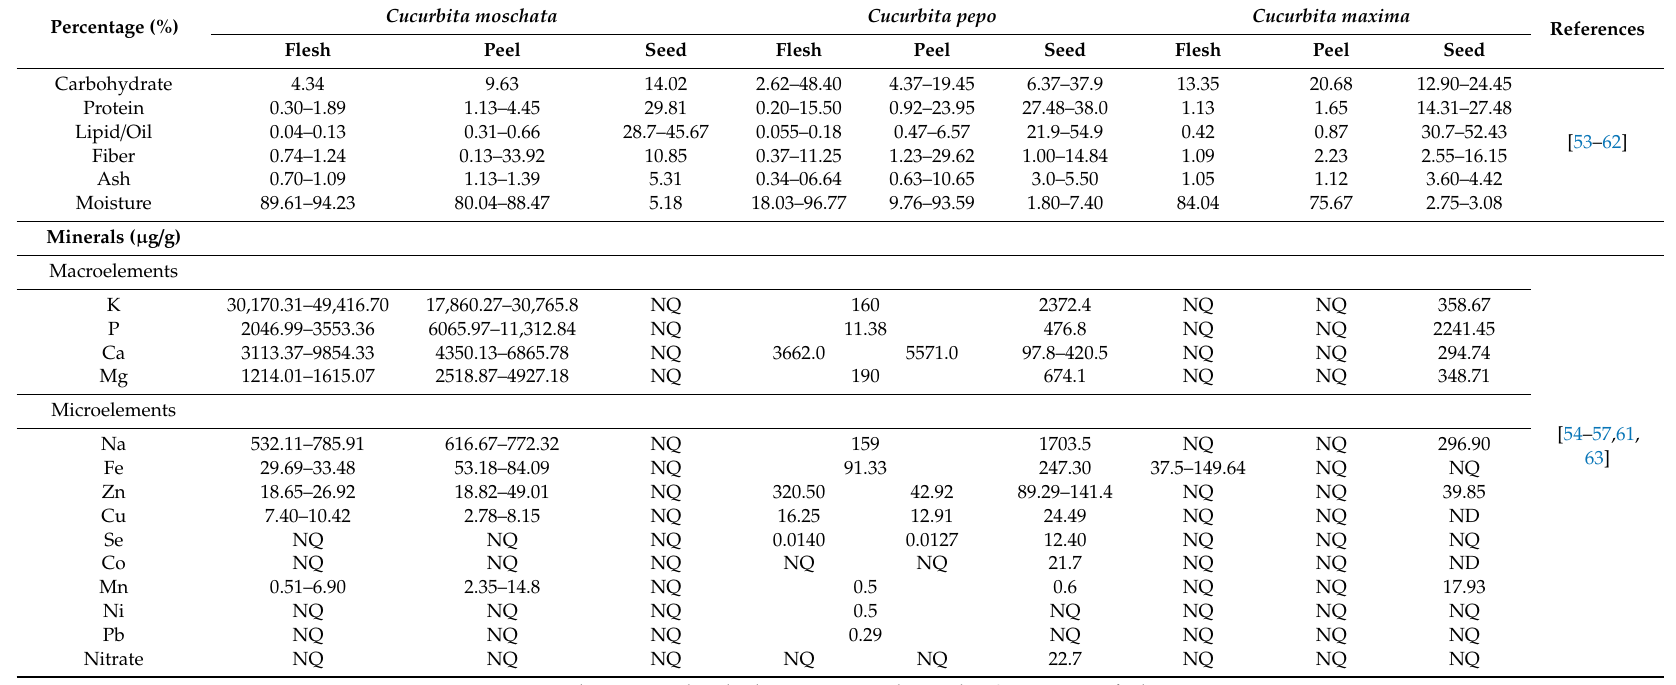
Table 1. Proximate composition of some common Cucurbita spp.